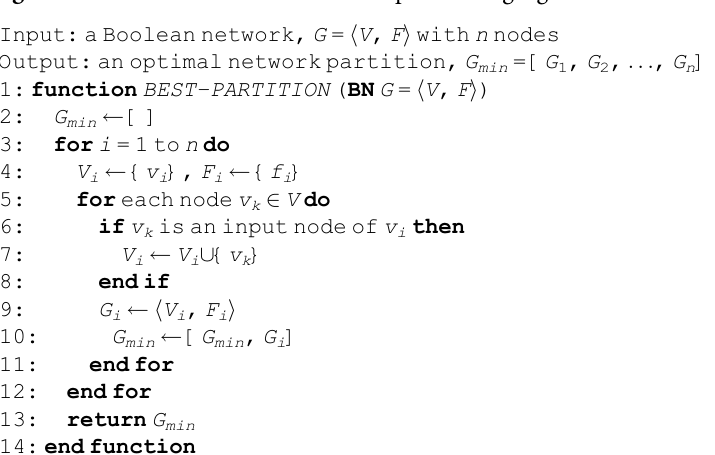
Algorithm 1 Pseudocode of the network partitioning algorithm